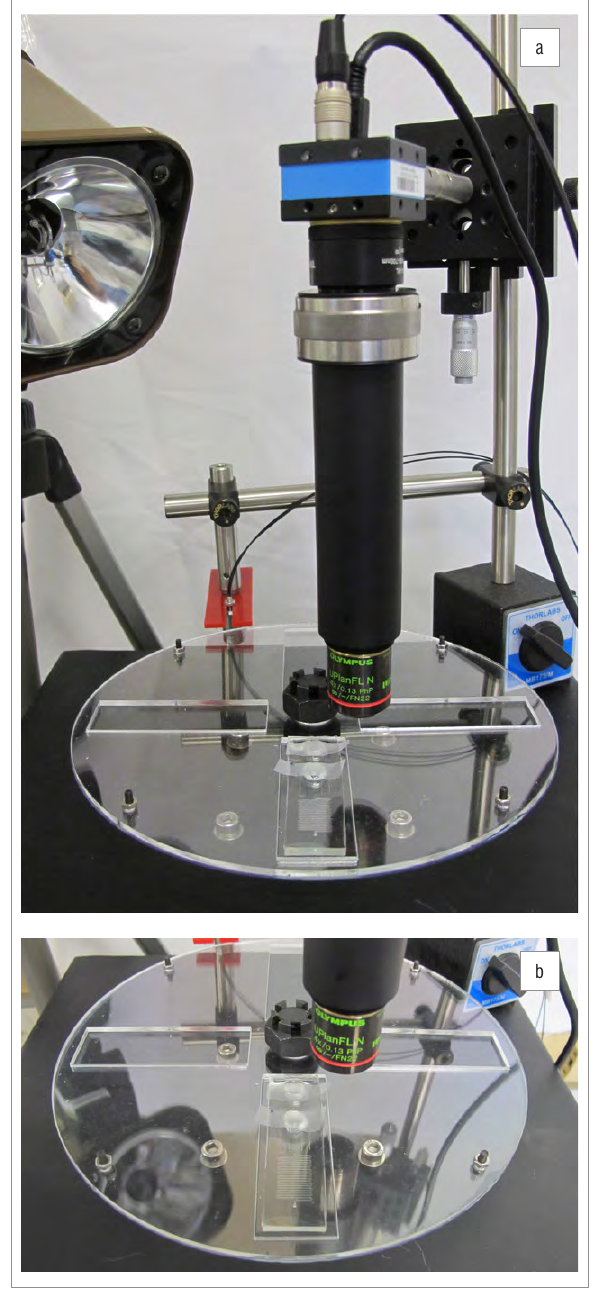
(a) Microscope set-up for capturing images of the droplet generation experiments, and (b) a close-up of the disc used to house the polydimethylsiloxane droplet-generation